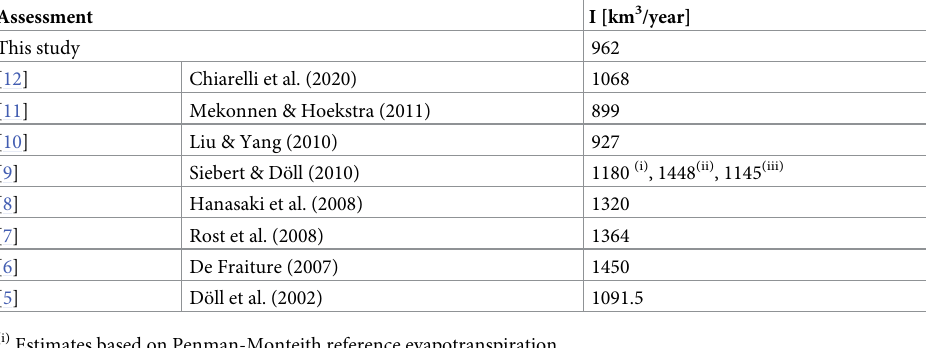
Table 3. Comparison of global estimations of irrigation requirement.